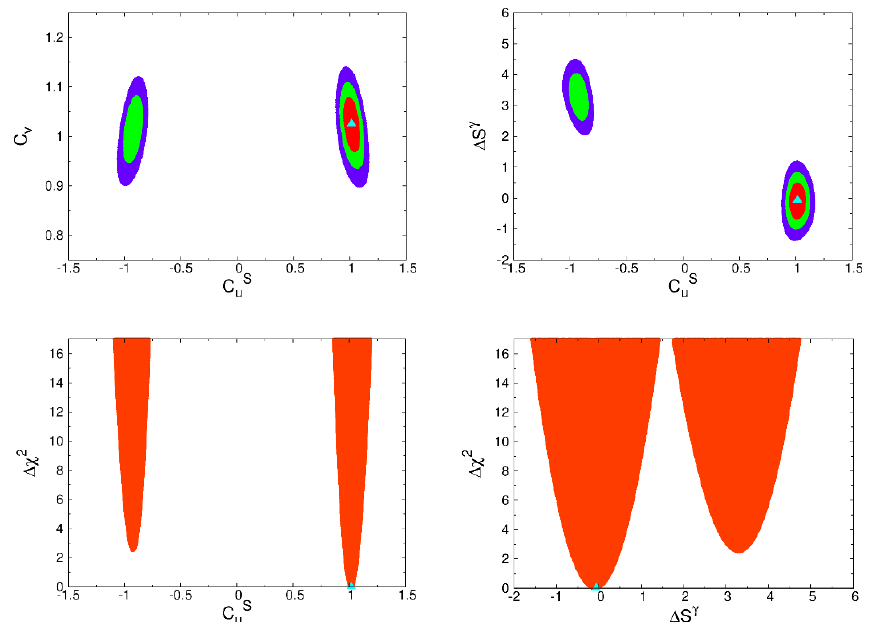
Figure 7 . CPCN3 : (Upper) The con(cid:12)dence-level regions of the (cid:12)t by varying (cid:1) S (cid:13) , C S C v . The color code is the same as in (cid:12)gure 2. (Lower) (cid:1) (cid:31) 2 versus C S